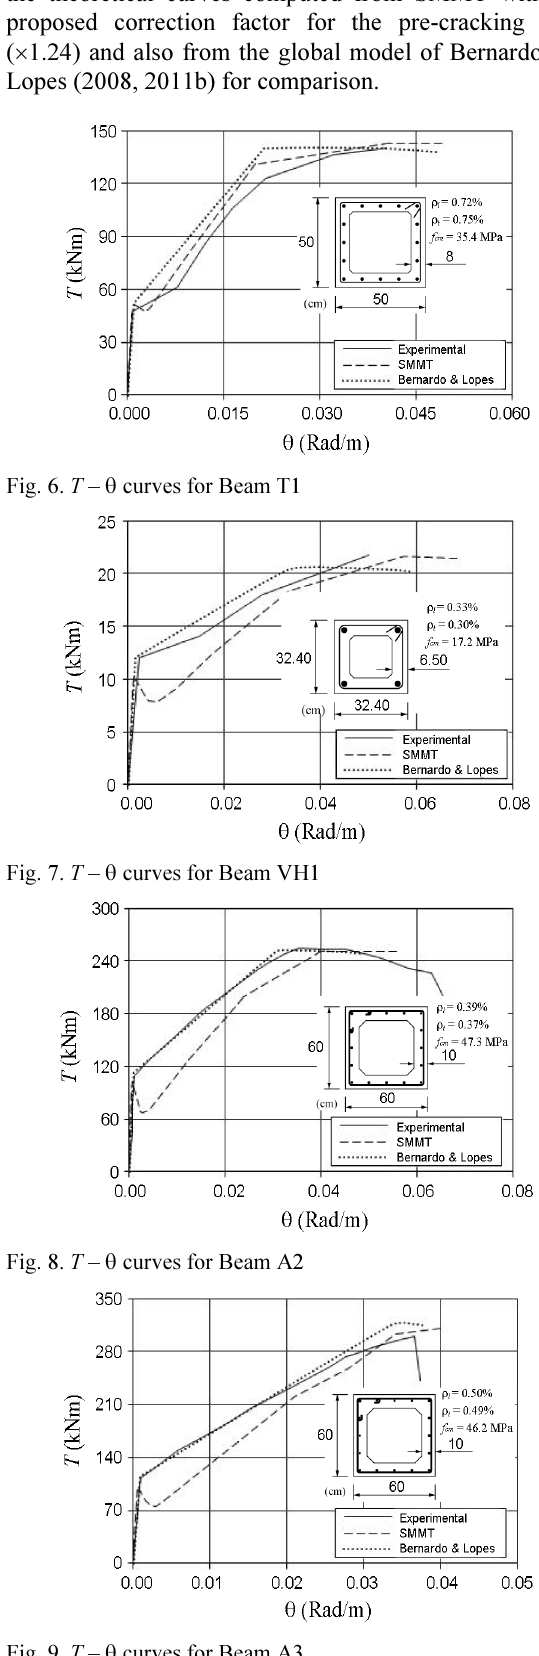
Fig. 9. T – θ curves for Beam